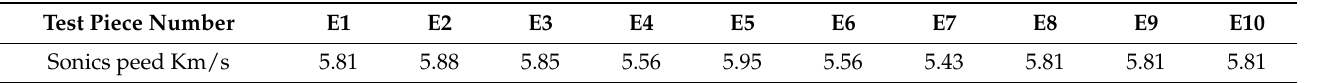
Table 1. Specimen acoustic test data.